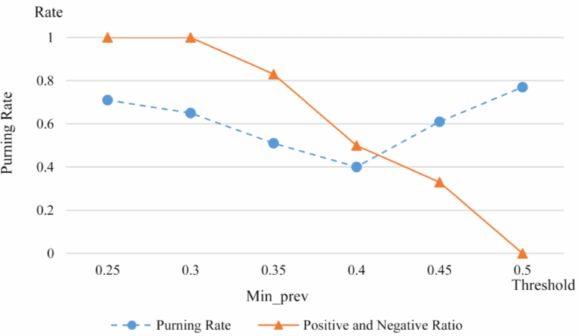
Figure 7. The relationship between the ratio of the number of positive and negative PT and the pruning rate.